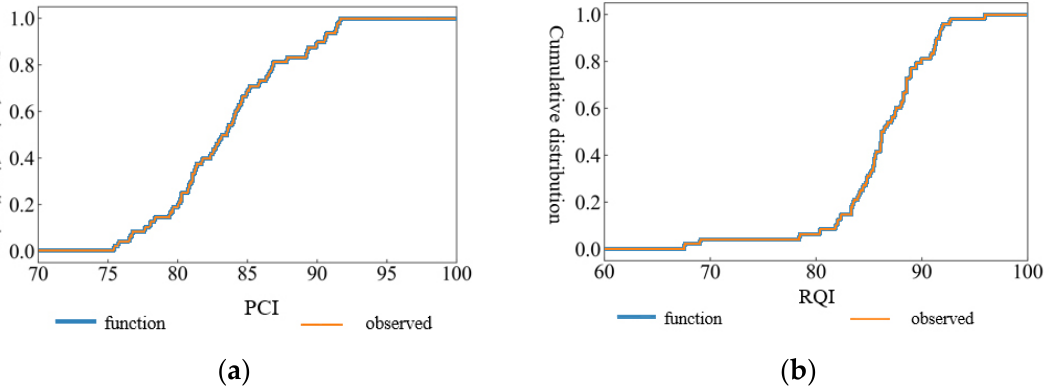
Figure 6. Continuity graph of the cumulative distribution of R4 pavement performance: ( a ) PCI; ( b ) RQI. The K-means algorithm was used to cluster the R4 unit evaluation road segments.